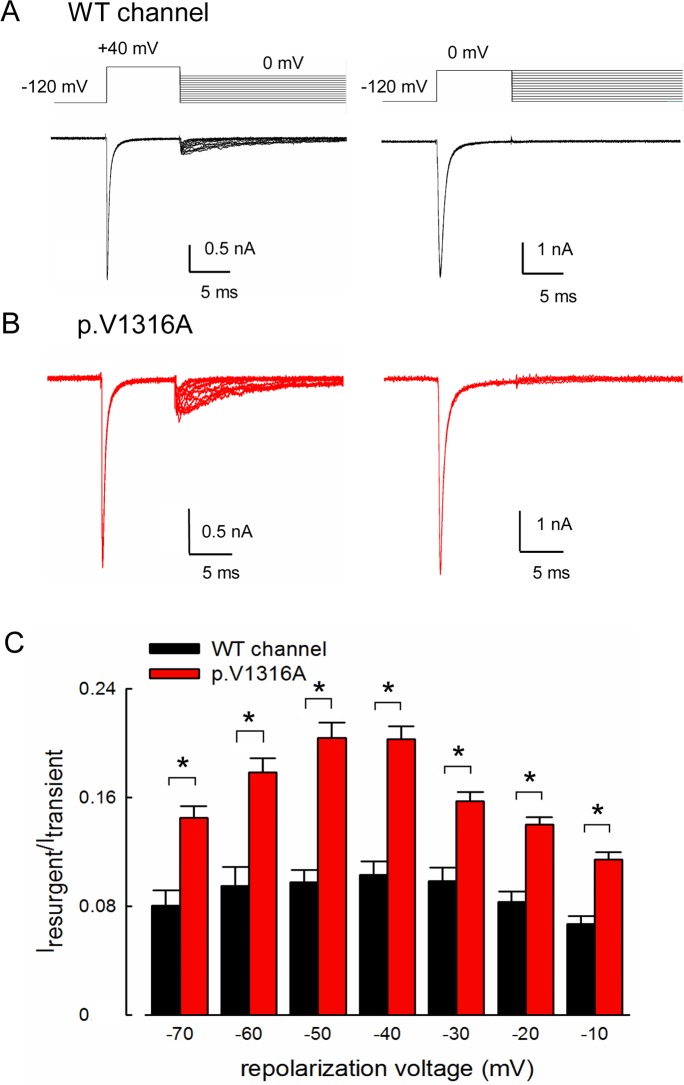
Larger resurgent Na+ currents in the p.V1316A mutant than that in the WT channels.(A) The cells were held at –120 mV, and the resurgent Na+ currents of WT channel were evoked by pulses between 0 and –120 mV in 10 mV increments following a depolarization prepulse of either +40 mV or 0 mV for 10 ms in the presence of the Navβ4 peptide. (B) Sample sweeps for the p.V1316A mutant channel in the presence of 0.1 mM Navβ4 peptide following the same protocol as part A. (C) Cumulative results were obtained from experiments described in part A for the WT and p.V1316A mutant channels (each n = 10). The ratio between resurgent and peak transient Na+ current (in the same sweep) is significantly larger in the p.V1316A mutant than WT channels at repolarization potentials between –10 and –70 mV. *, p < 0.05. Individual data is shown in the file of S1 Data.